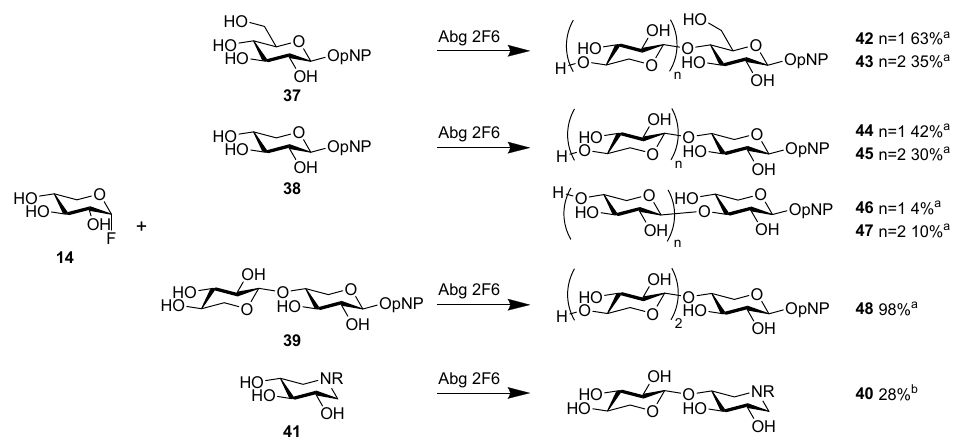
Scheme 7. Synthesis of various xylosides 40 , 42 – 48 by the glycosynthase Abg 2F6 derived from the β -glucosidase Abg of A. tumefaciens [44]. The enzyme exhibited variable selectivity depending on the acceptor substrate, producing predominantly β -1,4 linkages. a Yields determined by HPLC analysis of the reaction mixture; b Yield of isolated, acetylated product.